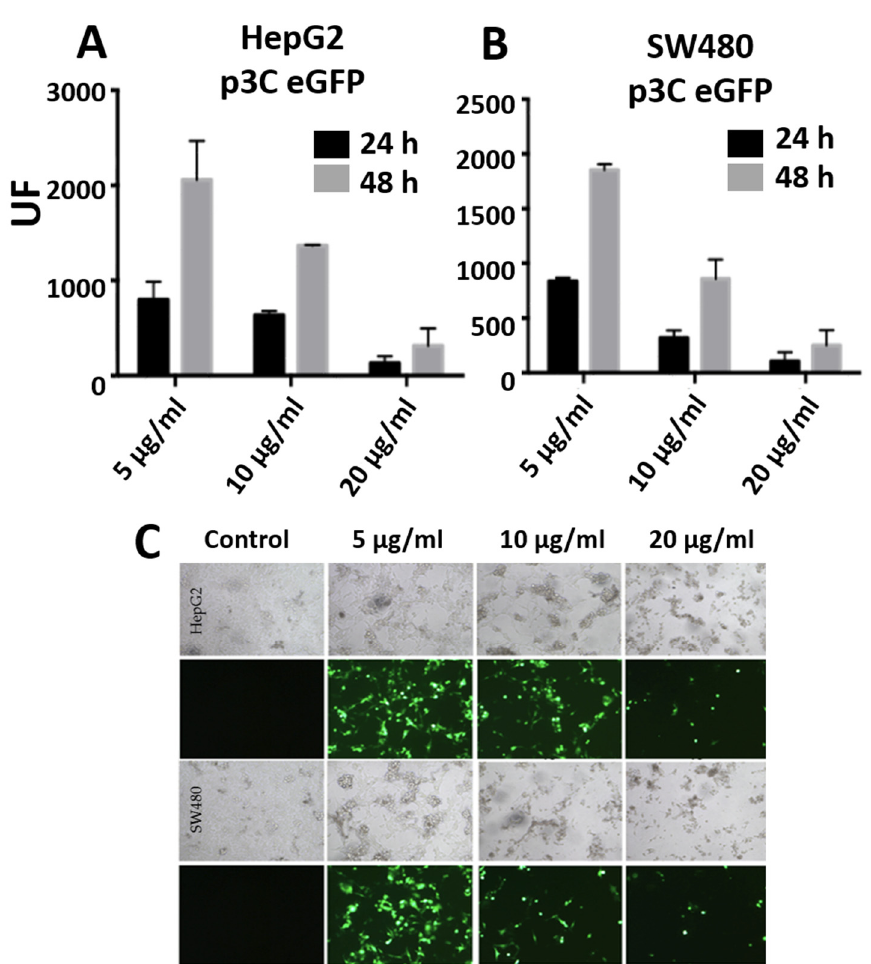
Figure 2. Graphs ( A , B ) represent fluorescence of HepG2 and SW480, respectively, 24 and 48 h after transfection with PEI ‐ AuNPs/p3C eGFP with 5, 10 or 20 μ g/mL of p3C eGFP at a relation of PEI ‐ AuNPs/p3C eGFP of 1:2.5 ( μ g/ μ g). Figure ( C ) shows the fluorescence microscope images of HepG2 and SW480 cells 48 h after transfection with PEI ‐ AuNPs/p3C eGFP at 1:2.5 ( μ g/ μ g) using different DNA concentrations. Images were captured at 20× magnification.